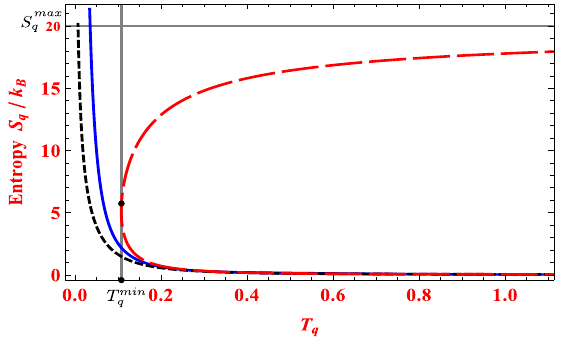
Fig. 2 The figure shows the temperature of a Schwarzschild BH as a function of masses in the asymptotically flat case with Boltzmann ( q = 1, blue-continuous) and Tsallis entropies ( q > 1, red-dashed and q < 1,